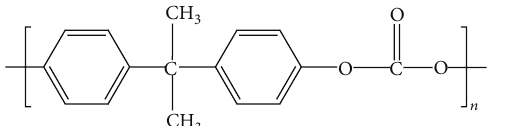
Figure 7: Chemical structure unit of polycarbonate, containing 14 atoms of hydrogen, 16 of carbon, and 3 of